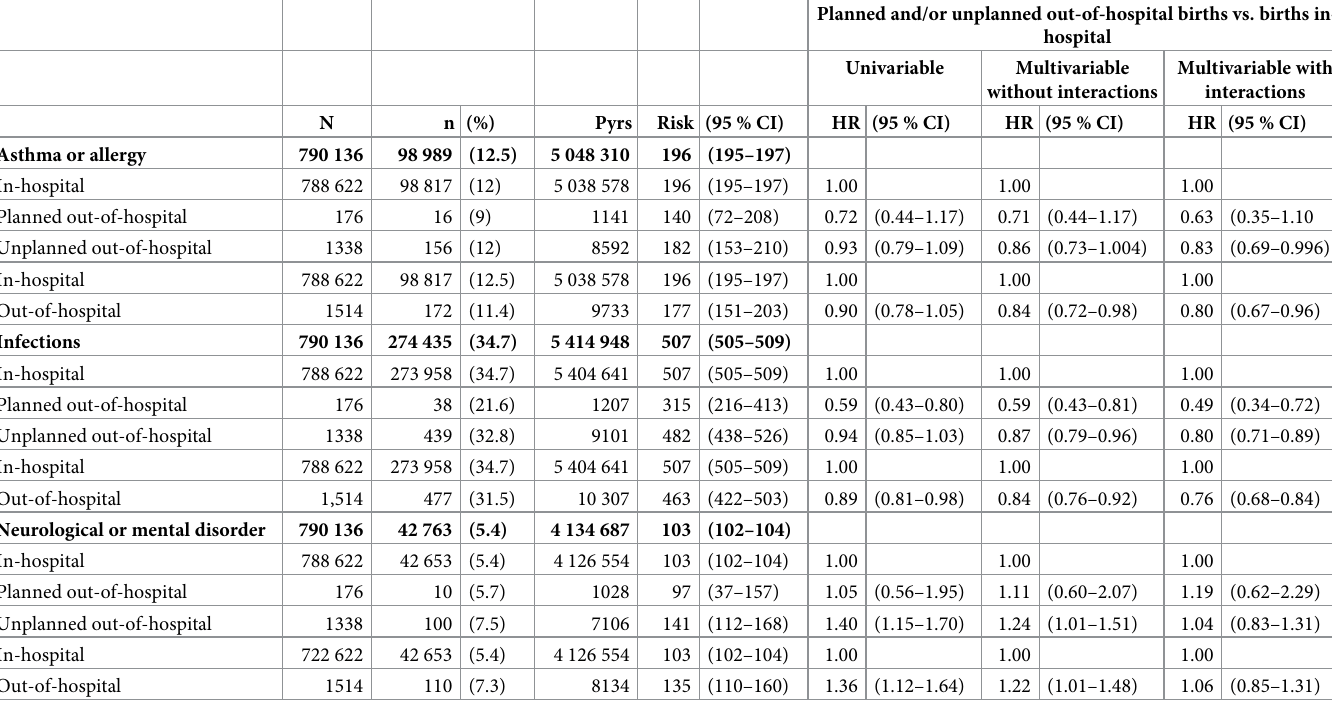
Table 6. Cox hazard regression models regarding hospital visits for asthma or allergy, infection, and neurological or mental disorder by the age of 7 years in the children born in-hospital, planned out-of-hospital, and unplanned out-of-hospital.